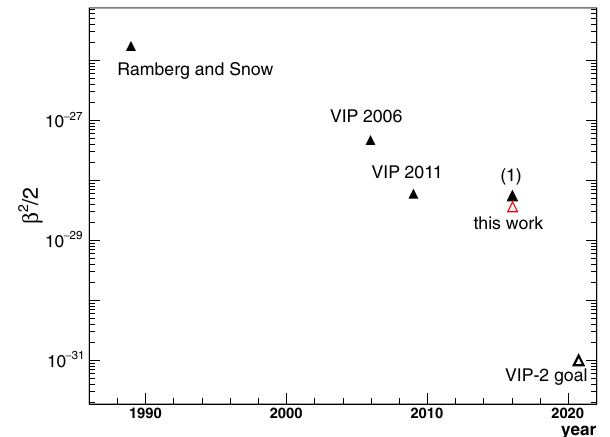
Fig. 10 PastresultsfromPEPviolationtestsforelectronswithacopper conductor, together with the result from this work and the anticipated goal of VIP-2 experiment. The result (1) is based on the same data set of this work, but using the spectra subtraction in the